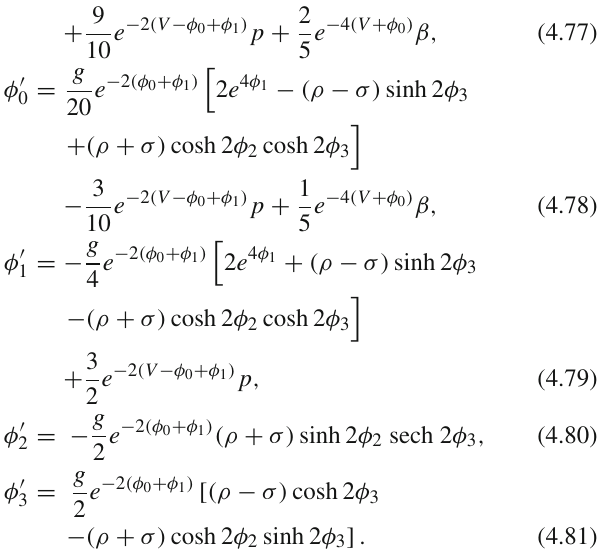
flat K 4 with k = 0, we have p = 0 by the twist condition k resulting in the standard flat domain wall